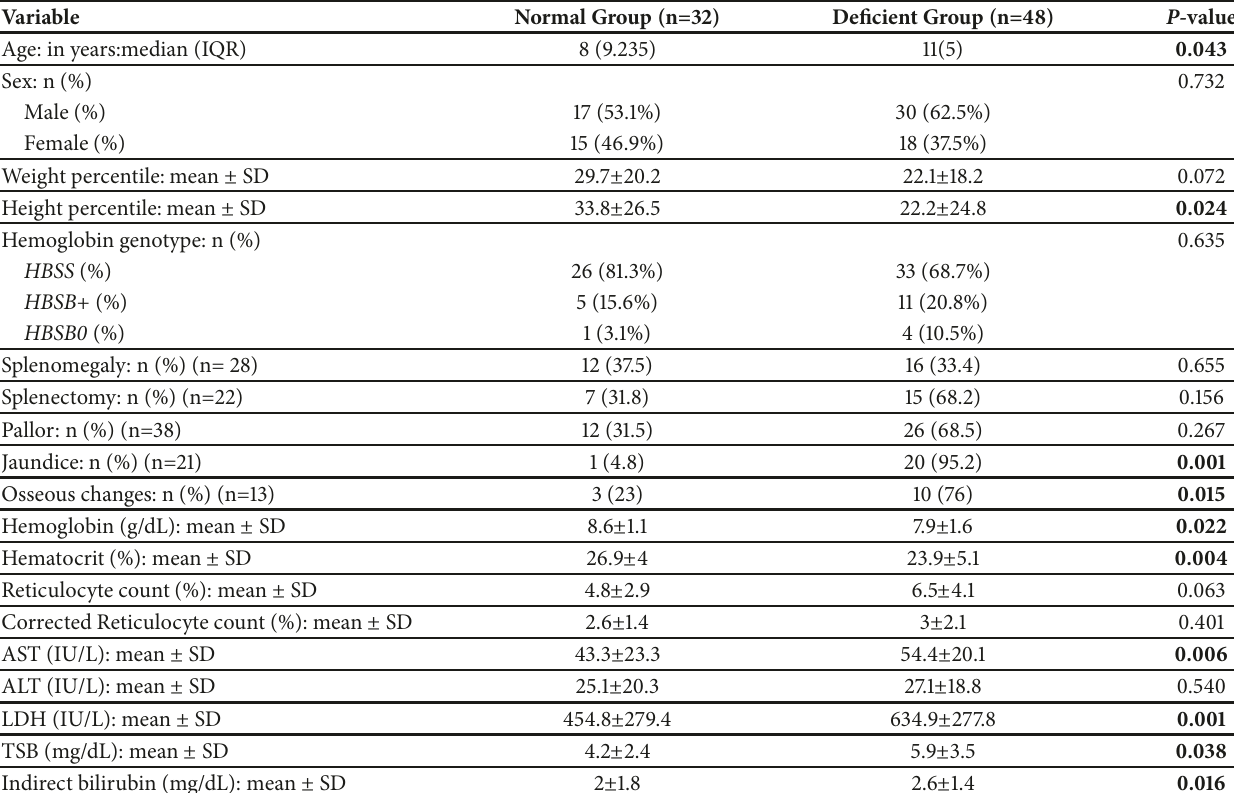
Table 3: Demographic and laboratory data of the 2 groups.